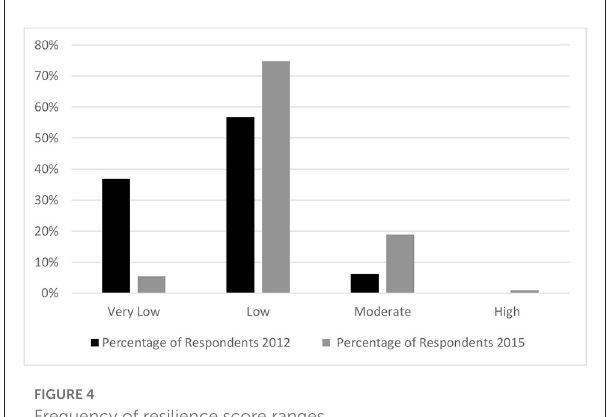
FIGURE4 Frequency of resilience score